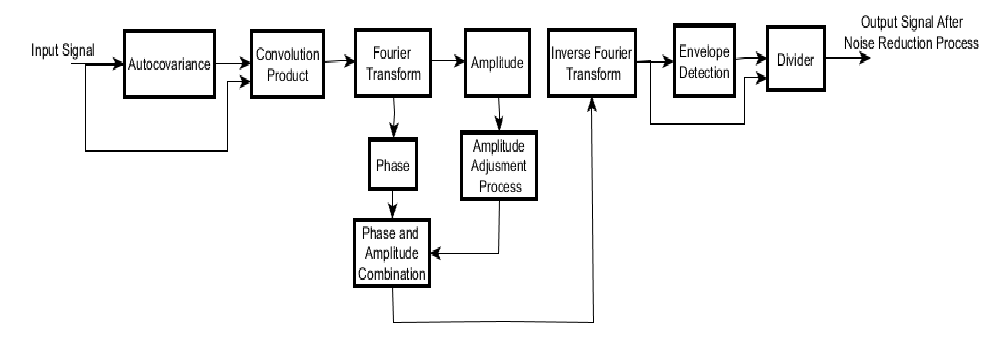
Figure 2. Representation of the noise-reduction algorithm workflow.